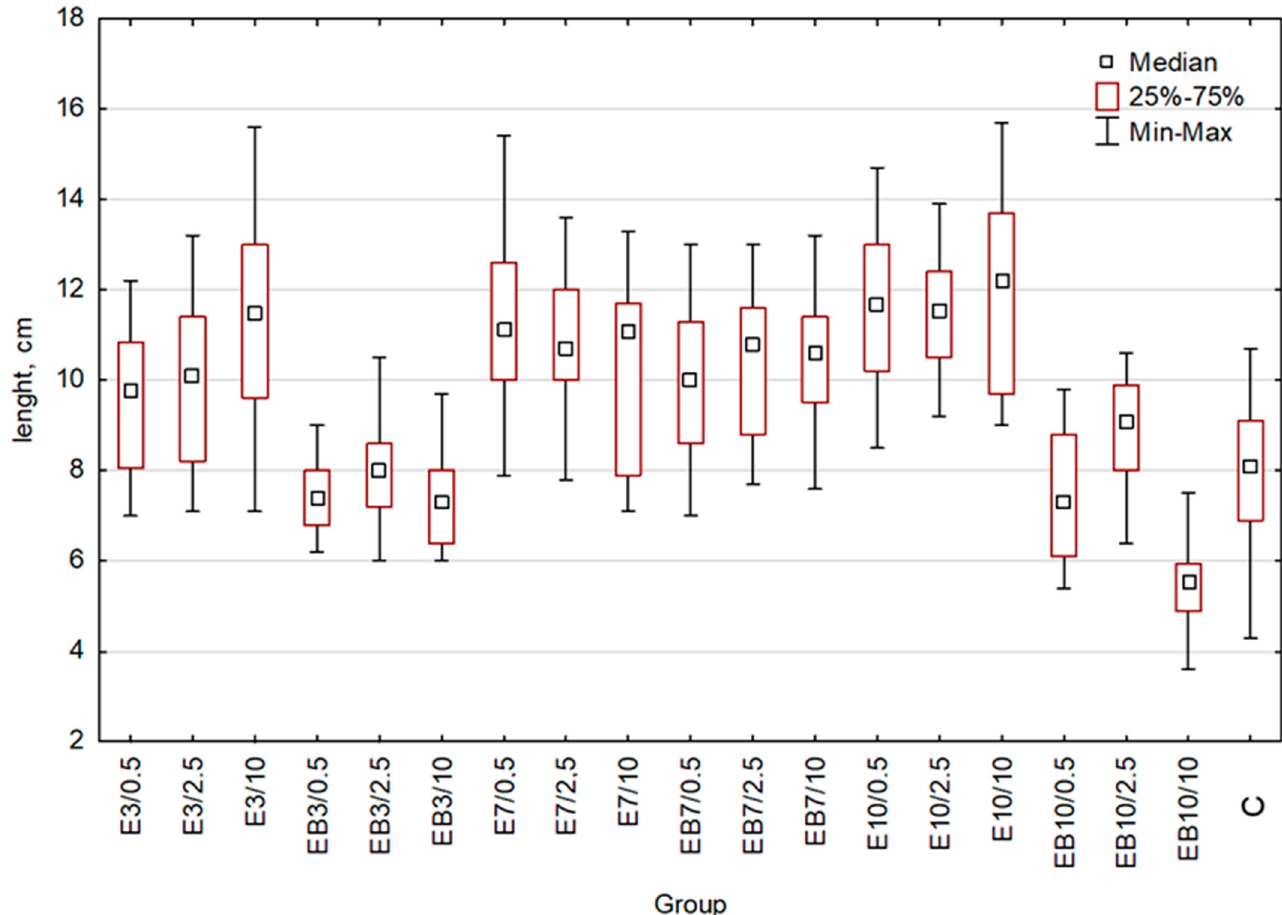
Figure 2. Wheat length comparison: whiskers represent the maximum and minimum, the box represents interquartile range (25–75%), square denotes the median for the entire sample. C-control, E3-group treated with the aqueous extract obtained at 25 °C pH = 3, E7-group treated with the aqueous extract obtained at 25 °C pH = 7, E10-group treated with the aqueous extract obtained at 25 °C pH = 10, EB3-group treated with the aqueous extract obtained at 75 °C pH = 3, EB7-group treated with the aqueous extract obtained at 75 °C pH = 7, EB10-group treated with the aqueous extract obtained at 75 °C pH = 10. Concentrations used: 0.5-concentration 0.5%, 2.5-concentration 2.5%, 10-concentration 10%.